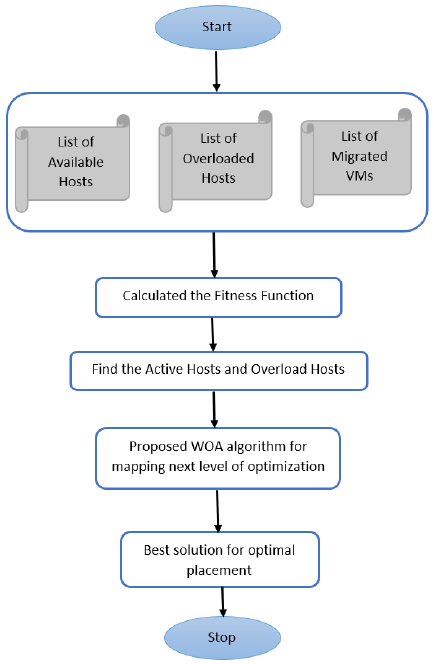
Figure 2. Workflow diagram of the CEWOAVM method.